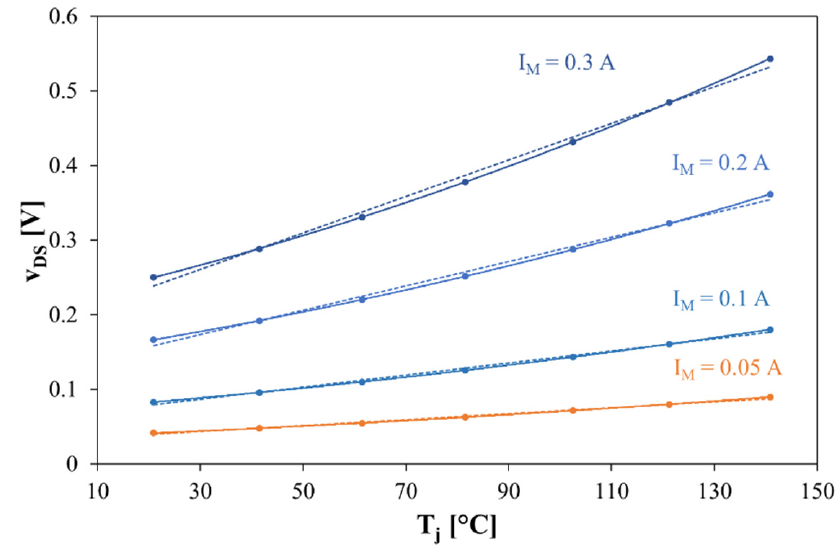
Figure 6. Dependence of voltage v DS on temperature T j at selected values of current I M for the